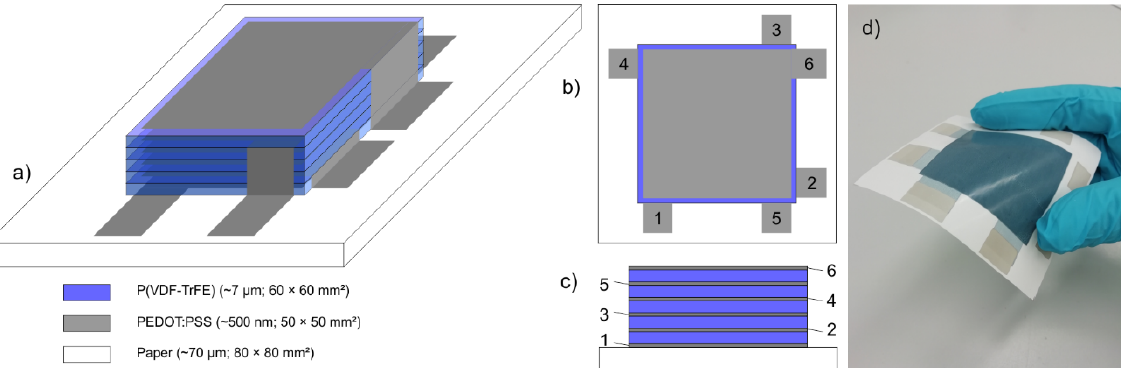
Figure 1. Multilayer device set-up: ( a ) 3D schema; ( b ) top view with electrode numbers on contact pads; ( c ) cross sectional view of the device with six electrodes and five active P(VDF-TrFE) layers; ( d ) Photo of the printed paper based transducer.